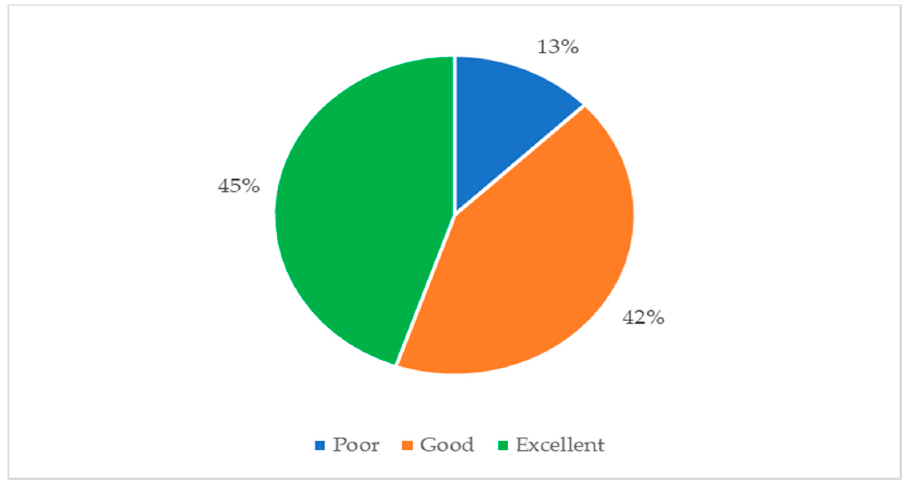
Figure 2. Classification of nursing students (n = 521) according to their SUS score. Table 2. Ordered logistic regression by DASS-21 scores (beta